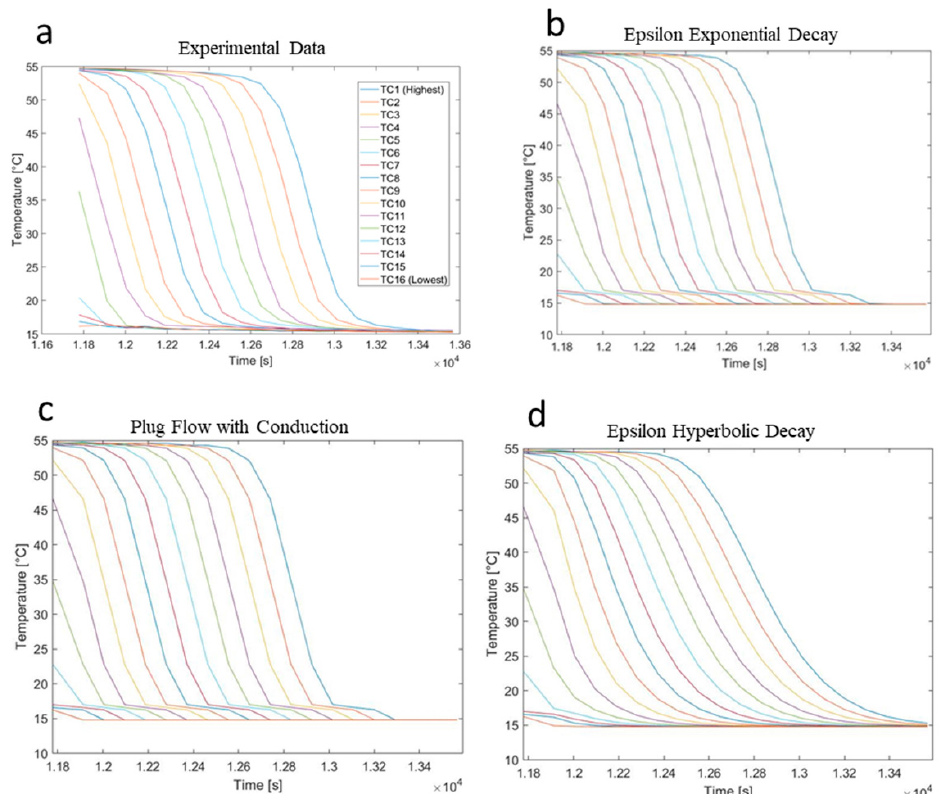
Figure 7. Discharge draws of 1.7 GPM for a cone diffuser without an anti-siphon orifice. ( a ) Experimental data; ( b ) ε model using exponential decay; ( c ) plug-flow model with the inclusion of conduction in the water; and ( d ) ε model using hyperbolic decay.